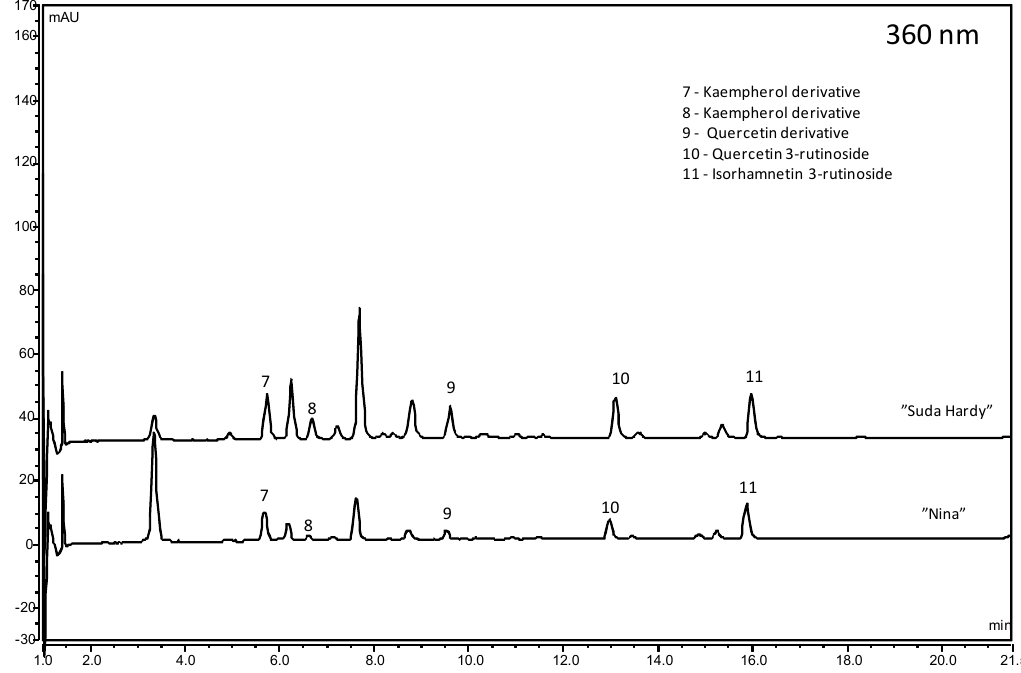
Figure 2. Chromatograms (360 nm) of sour cherry fruit cultivars with the highest and the lowest content of flavonols.